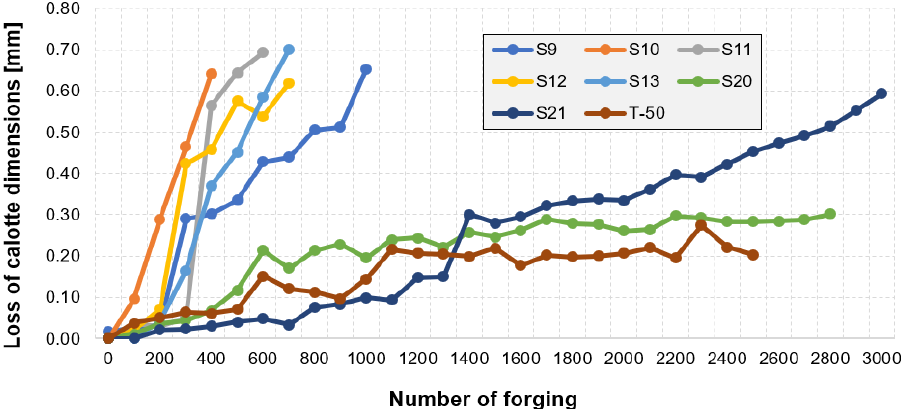
Figure 10. Diagram of the calotte’s height loss by the reverse scanning method from cyclically collected forgings for selected